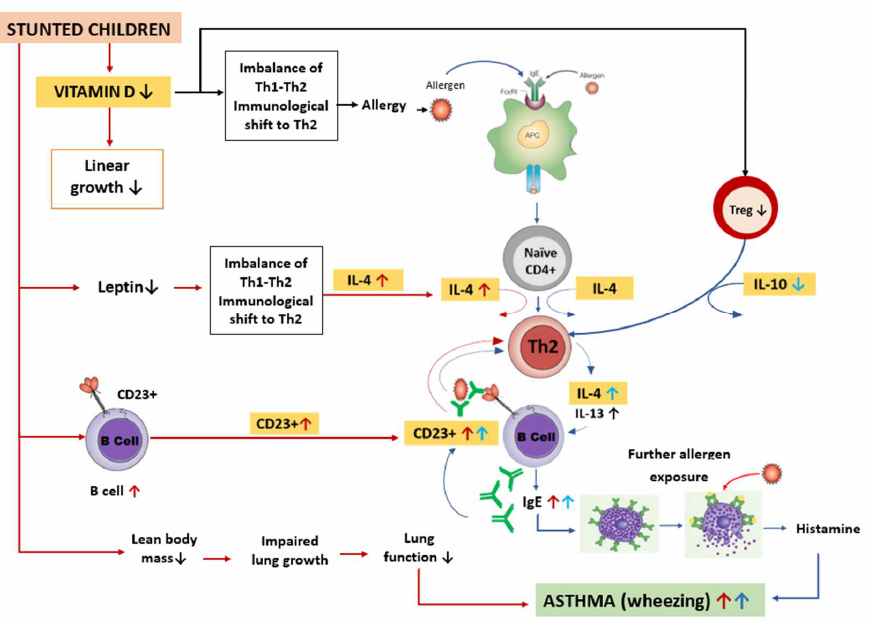
Figure 4. Possible mechanism of asthma in stunted children. Stunted children have lower vitamin D levels, resulting in decreased linear growth. Low vitamin D levels cause changes in the Th1–Th2 balance toward Th2, promoting allergic diseases including asthma. The pathophysiology of asthma begins with exposure to allergens captured by APC, which are then presented to naïve CD4+ cells. With the help of IL-4, naïve CD4+ cells differentiate into Th2 cells that produce IL-4 and IL-13. Thereafter, B lymphocytes differentiate into plasma cells that produce IgE and attach to the mast cells. Further exposure to allergens and crosslinking of allergens with IgE occur on the outer surface of membrane of mast cells, resulting in degranulation, histamine release, and bronchoconstriction, leading to asthma symptoms such as wheezing. In addition, when vitamin D levels are low, the number of Tregs decreases, thereby lowering IL-10 production. This causes an increase in Th2 activity and IL-4, resulting in an increase in IgE, which further stabilizes the CD23+ B cells. B cells take up allergen–IgE complexes and present the allergen to Th2 cells, thereby increasing the Th2 response. In stunted children, there is a decrease in lean body mass that causes impaired lung growth and decreased lung function. In addition, low leptin levels cause changes in the Th1/Th2 balance toward Th2 cells, thereby increasing IL-4 production. B cells also increase, causing an increase in CD23+ levels. All these factors contribute to asthma occurrence in stunted children.